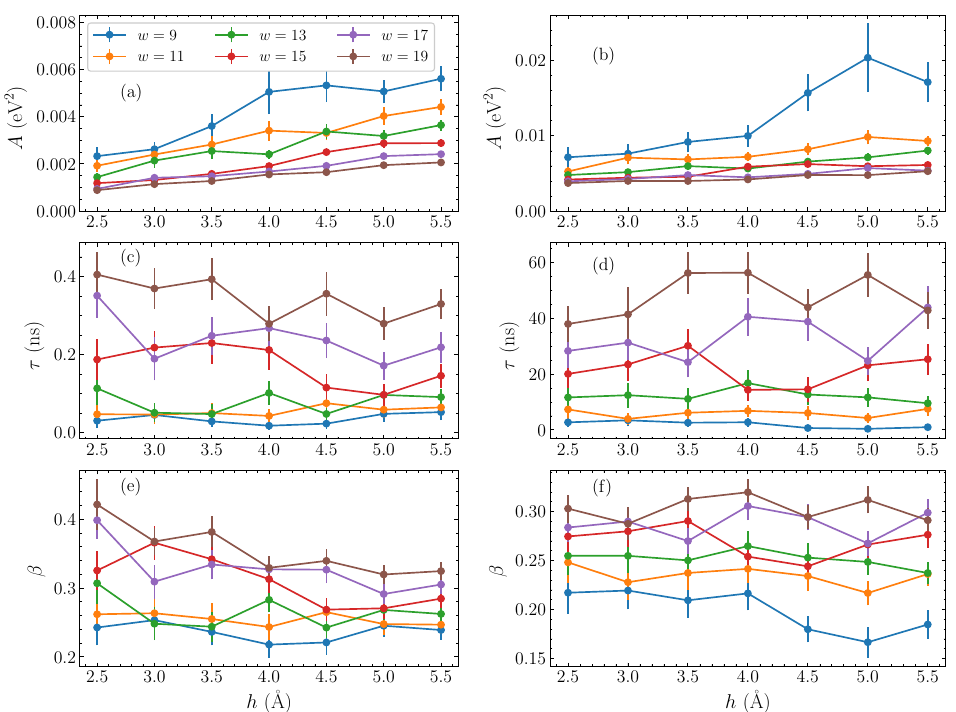
Figure 4. The stretched exponential parameters of Equation (10), as fitted to the energy autocorrelation functions C E ( t ) (Equation (8)), as functions of the amplitude h , for varying widths w (presented by different colors) of the initial bubble perturbation. The left column shows the parameters for AT sequences, and the right column for GC sequences. ( a , b ) the pre-exponential coefficient A ; ( c , d ) the characteristic time constant τ ; ( e , f ) the stretched exponent β . The line connections are used to guide the